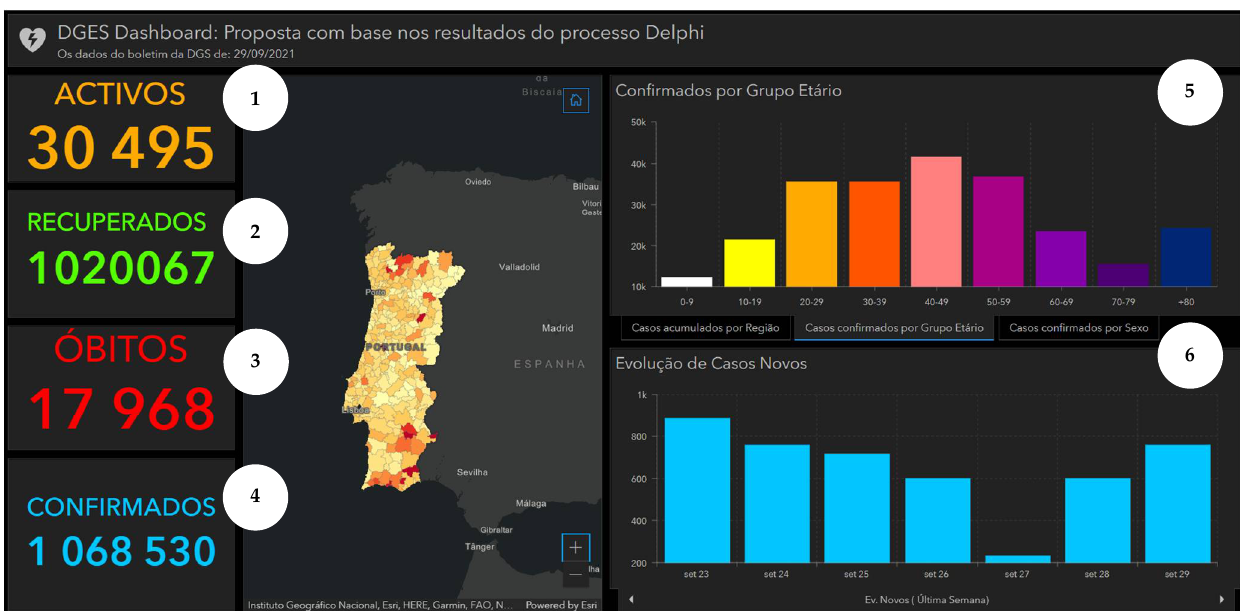
Figure 4. Illustrative representation of the adjusted DGS COVID-19 Dashboard produced with ArcGIS [44]. Note: The figure content is written in Portuguese. The text on top of the dashboard informs that the adjusted dashboard is a proposal based on the Web-Delphi process results. Below three columns with statistics, a map and charts are presented. First column shows COVID-19 statistics: 1—Number of Active Cases, 2—Total Number of Recovered, 3— Total Number of Deaths, 4—Number of Confirmed Cases; second column presents a map of Portugal with Cumulative incidence per 100,000 hab. by Municipality, on 29 September 2021; third column show (from top to bottom): 5—Number of Cases (y-axis) per Age Group (x-axis), 6—Evolution of New Cases between 23 and 29 September 2021). On chart 5, three tabs pointing to three charts are available (from left to right): Cumulative cases by Region, Confirmed Cases per Age Group (selected) and Confirmed Cases by Sex.